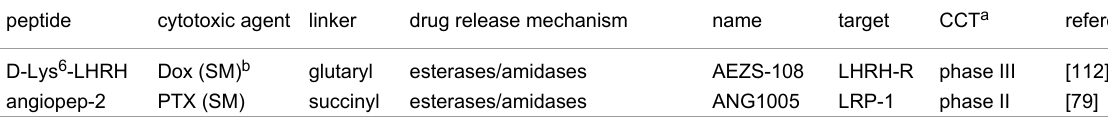
Table 3: Peptide–drug conjugates consisting of peptides and small molecules that have been used in clinical trials. peptide